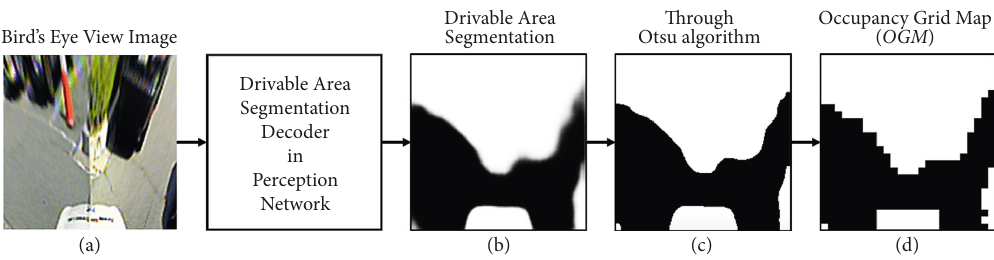
Figure 4: Process of drivable area segmentation to obtain occupancy grid map ( OGM ) .